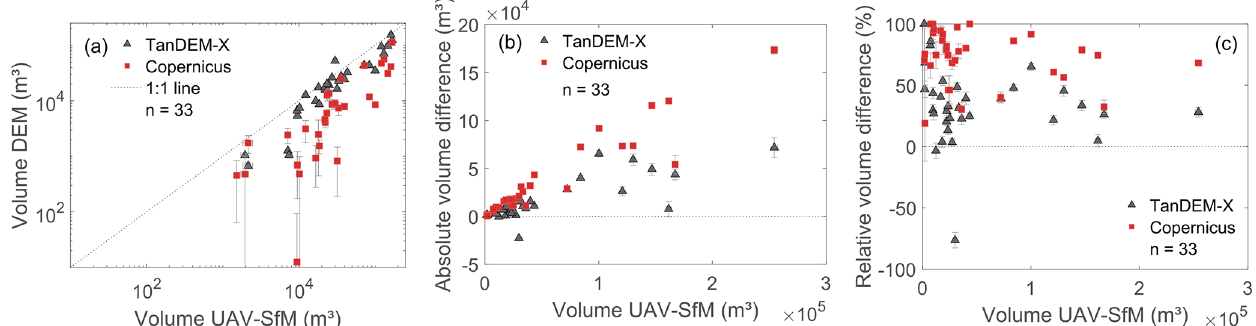
Figure 3. Pairwise volume comparison. (a) Direct volume comparison between the lavaka volume obtained from the 0.2m resolution UAV- SfM DEM and 12 and 30m resolution TanDEM-X and Copernicus DEMs. The black line indicates the 1 : 1 line. Values are plotted on a log–log scale. (b) Absolute and (c) relative volume difference with the UAV-SfM DEM. The dotted horizontal line indicates the zero- difference level. Grey error bars are the standard deviations of the mean calculated volumes representing the total uncertainty (interpolation and relative DEM uncertainty).